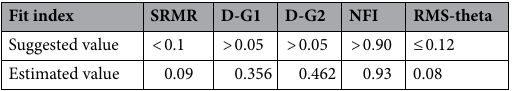
Table 3. Summary of goodness of fit indices for the measurement